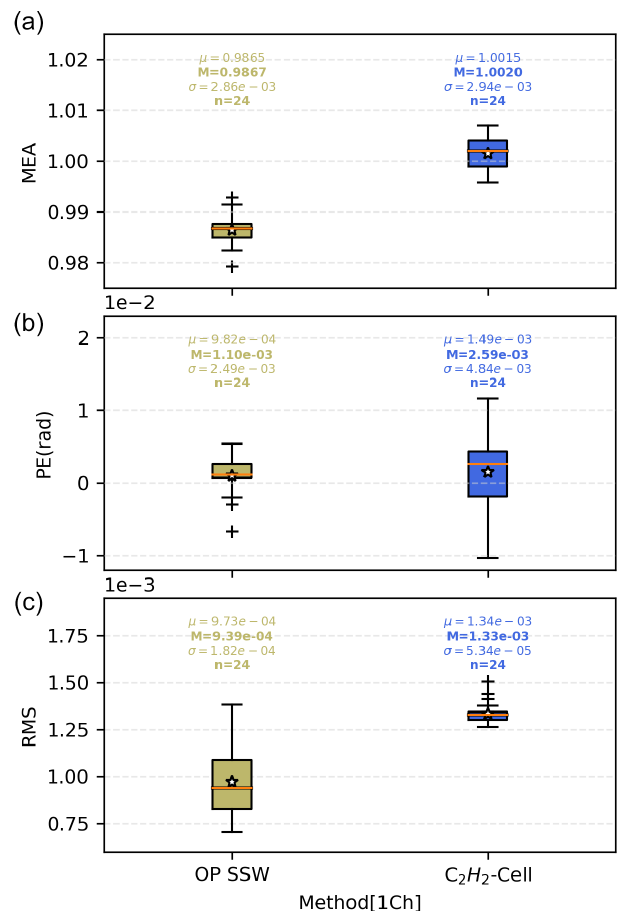
Figure 19. MEA and rms statistical results from the ILS retrievals by using the OP and the cell methods for the first channel of the available instruments (left part of the display: open path; right part: